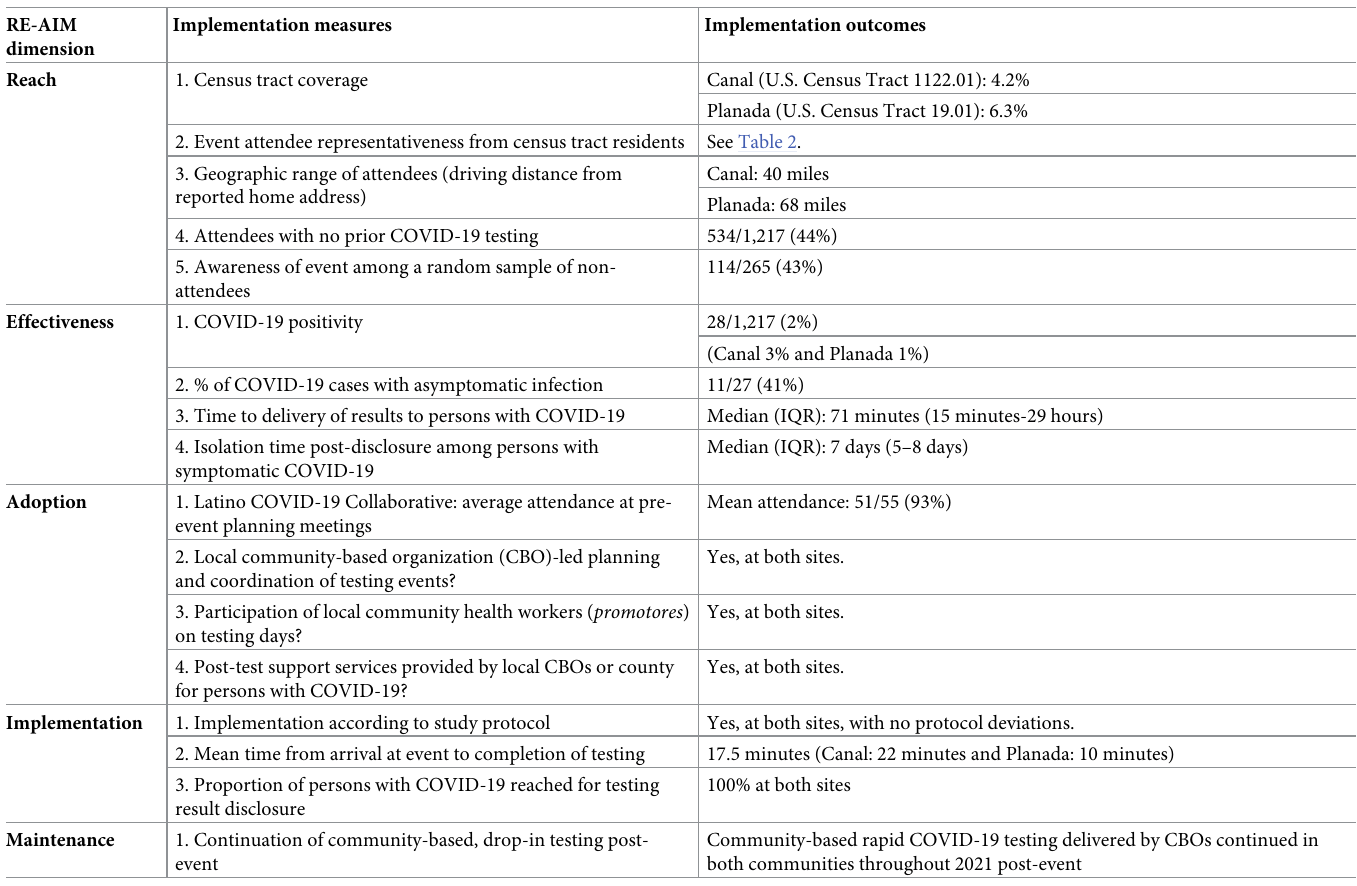
Table 3. RE-AIM implementation evaluation framework of the mass testing event intervention March-April 2021 in two predominantly Latino, low-income com- munities in Northern California. RE-AIM